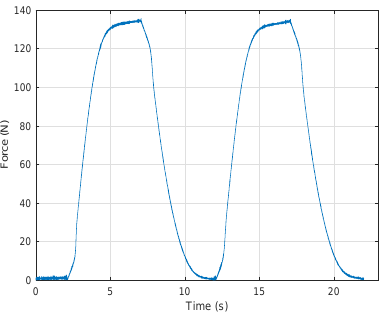
Figure 23: 6-DOF Industrial Robot: two force applica- tion cycles.